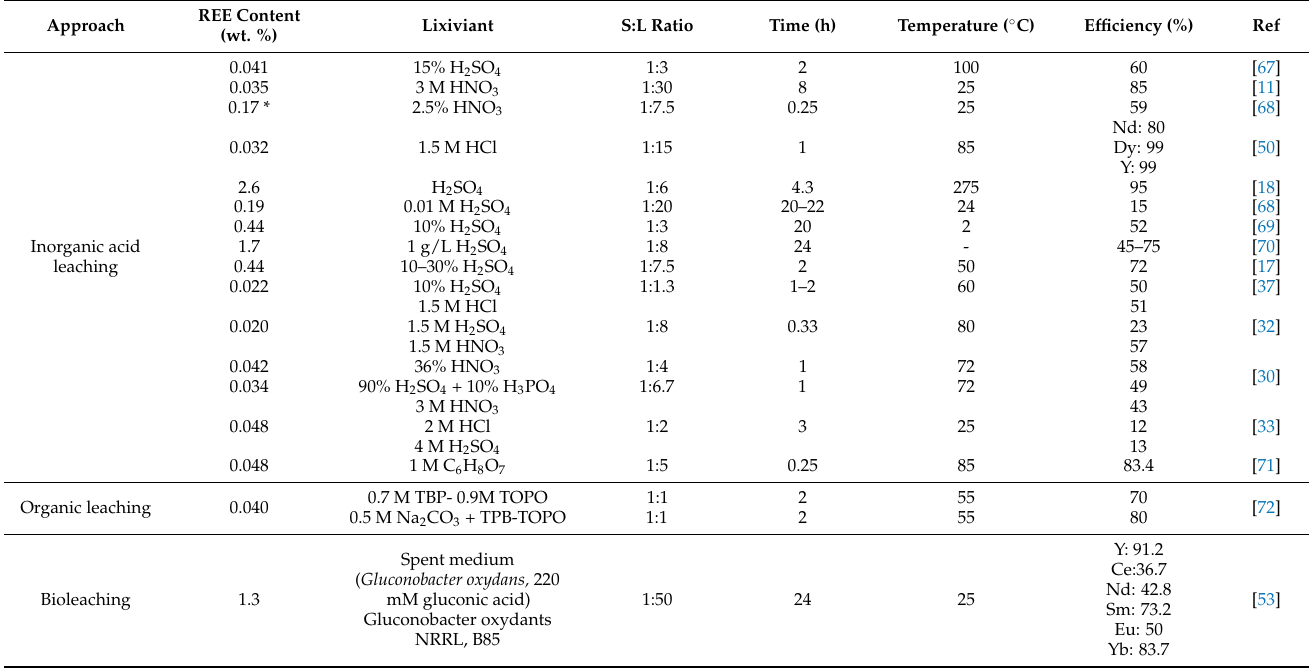
Table 3. Leaching efficiencies of REEs from PG using various leaching